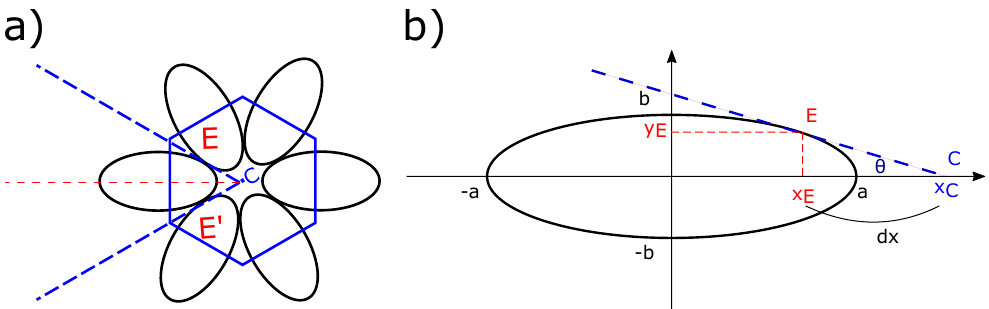
Figure 5. ( a ) Projection of a group of six Focal Conics in the (xOy) plane and ( b ) Zoom in on one particular ellipse; θ denotes the angle between the major axes of the ellipse and the tangent line passing through C to the